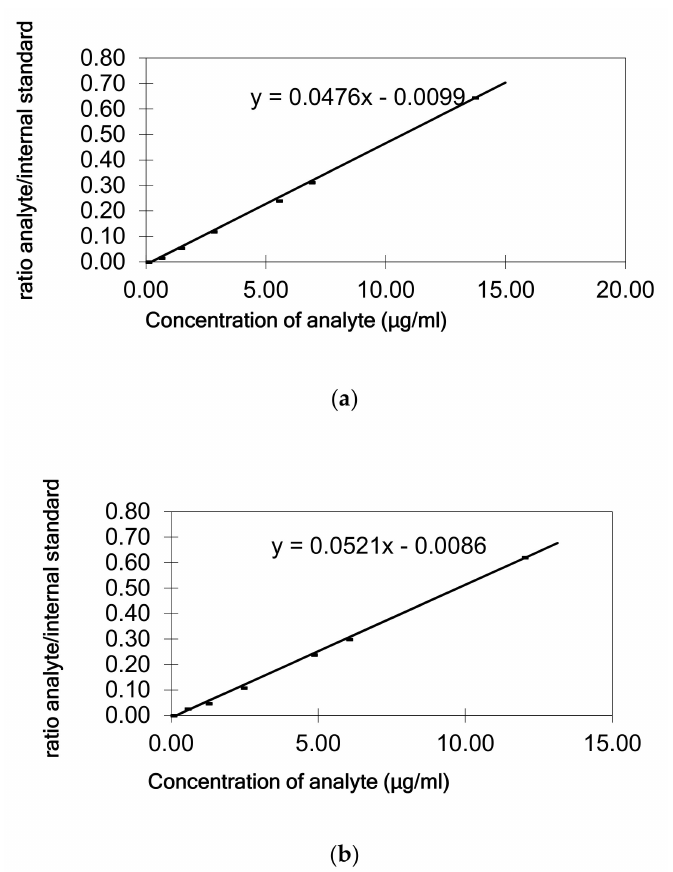
Figure 3. Calibration graphs: ( a ) palmitone in heptane; ( b ) stearone in heptane.